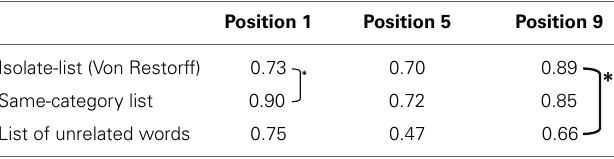
Table 2 | Probability of recall for the critical word, within the different embedding lists.